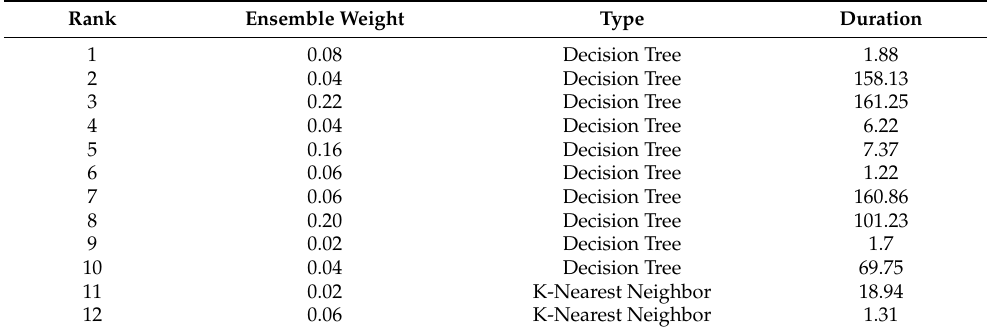
Table 5. The result of model selection performed by auto-sklearn when considering all ten outputs (Scenario